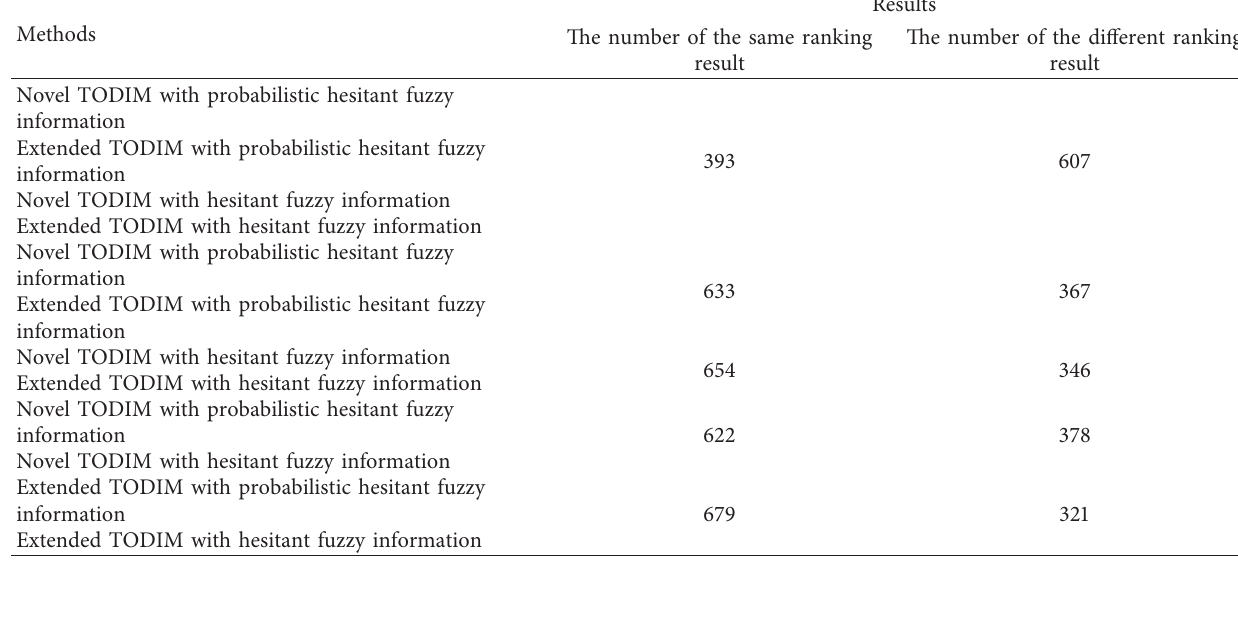
Table 22: Ranking results of each method with 1000 sets of random